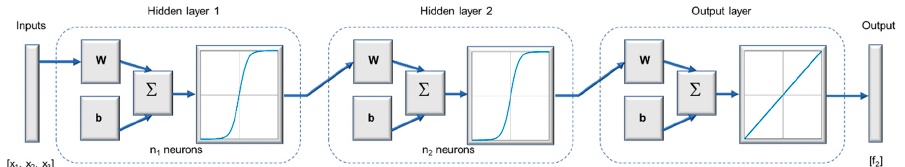
Figure 15. ANN with two hidden layers for modeling 𝑓 (cid:2870) .